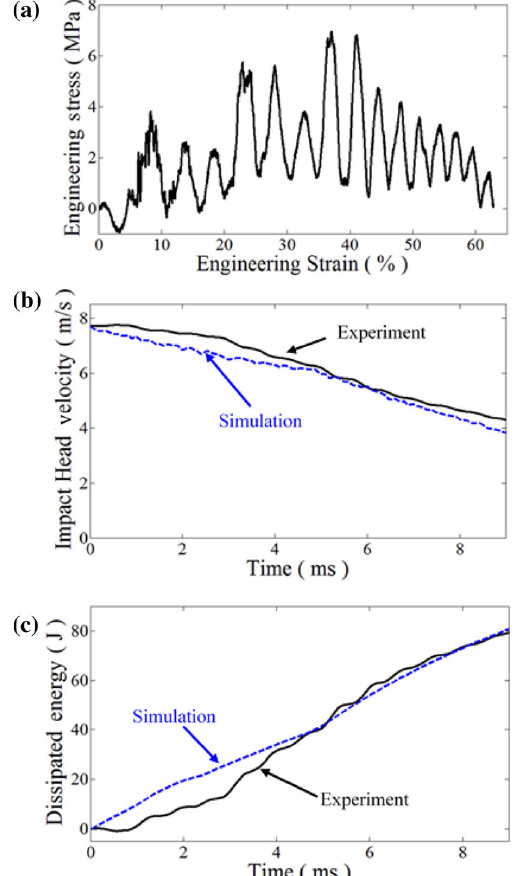
Fig. 3 Typical impact testing and computer simulation results: a the dynamic stress–strain relation; b the drop-mass velocity; and c the absorbed